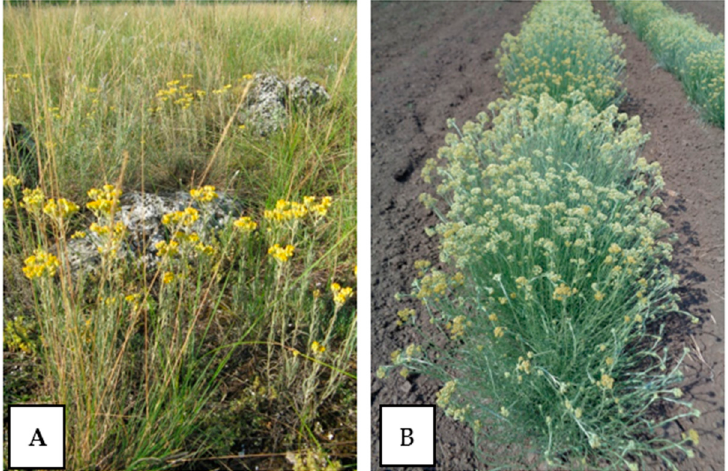
Figure 2. Wild population of Helichrysum arenarium of population Pobitite kamani, near Varna town ( A ), cultivated Helichrysum italicum ( B ).